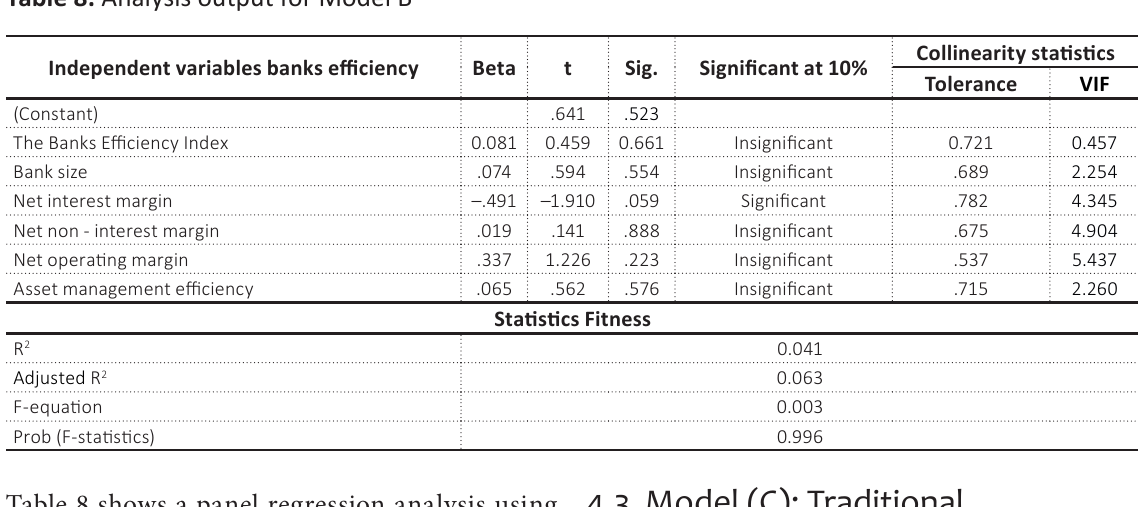
Table 8. Analysis output for Model